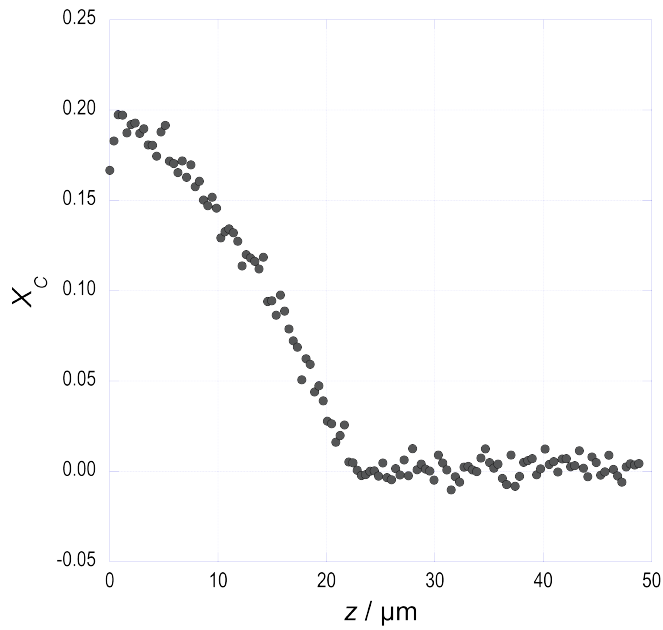
Figure 4. Atom-fraction–depth profile X C [ z ] of carbon in low-temperature-carburized AISI-AL-6XN, acquired by scanning Auger microprobe. The alloy was activated by etching in concentrated aqueous HCl, immersing in C 2 H 5 OH, and drying in N 2